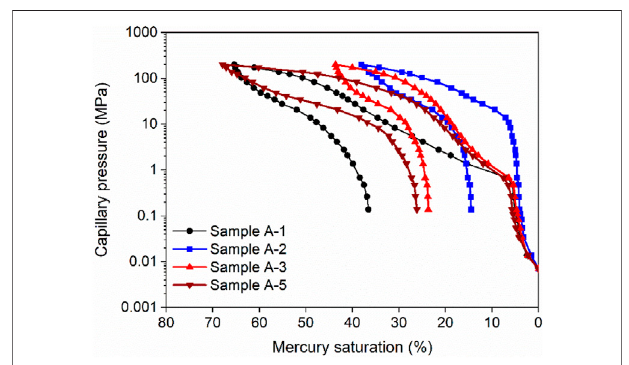
FIGURE 6 | Capillary pressure curves of representative shale samples from well Anye A well platform.